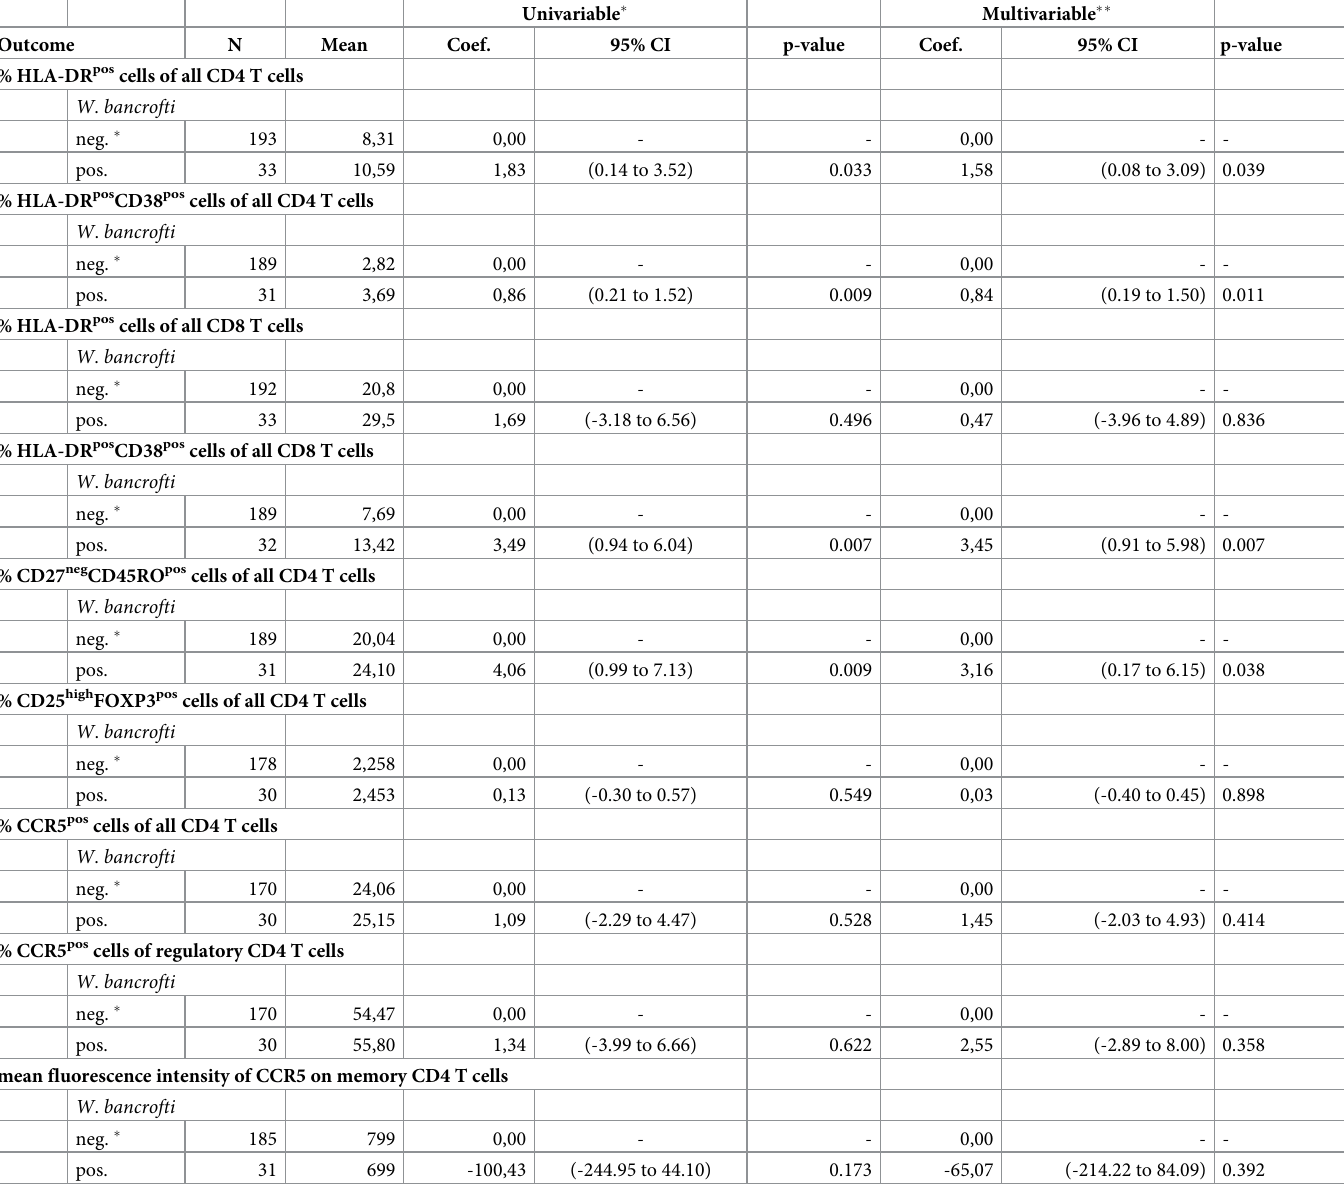
Table 3. Associations of filariasis infection with different markers of immune activation. Separate uni- and multi-variable mixed-effects linear regression models for each marker with random effect for residence at Kyela site. Differences in number of observations are due to missing outcome data. Univariable � Multivariable